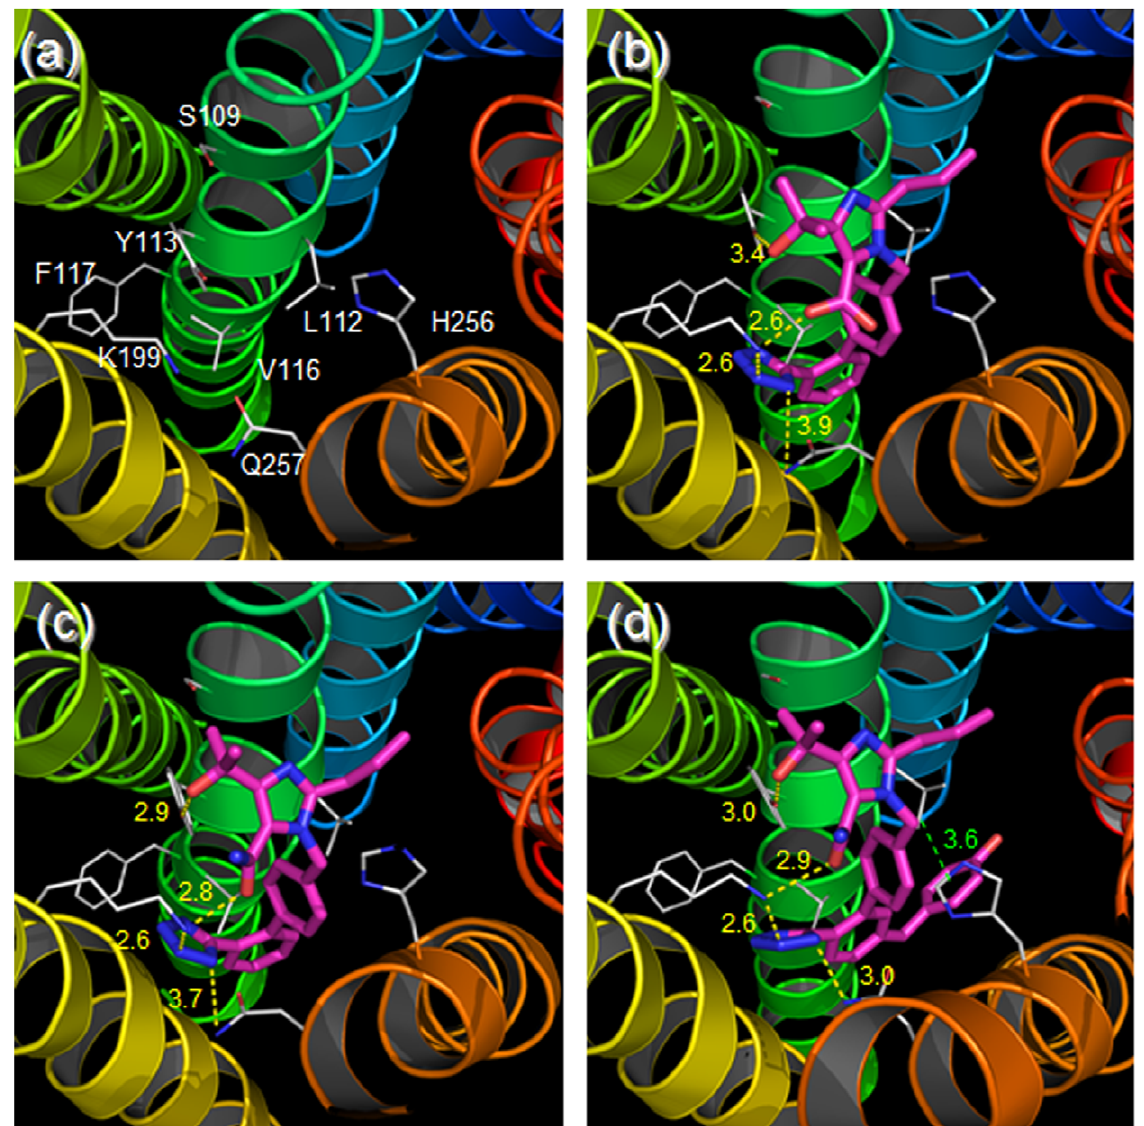
Figure 5. Putative binding mode of various ligands in AT 1 receptor. Transmenbrane (TM)1–7 are shown as colored ribbons: blue (TM1), cyan (TM2), green (TM3), lime green (TM4), yellow (TM5), orange (TM6) and red (TM7). Sidechains of the focused residues are shown as gray lines, and ligands are represented as magenta sticks. The hydrogen bonds and electrostatic interactions are indicated by yellow dotted lines. The distance between Leu 112 and the hydroxyphenyl moiety of R794847 is represented as a green dotted line. The unit of distance was A˚. (a) without ligand, (b) olmesartan, (c) R239470, (d) R794847.